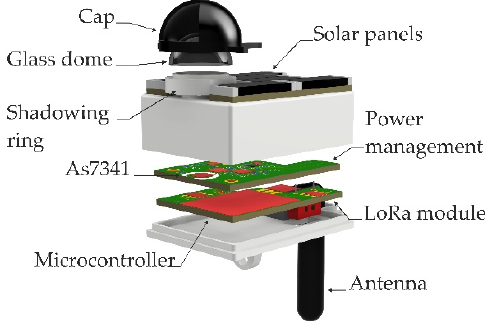
Figure 1. Sensor node of the ILAISS and its components (Rendering).